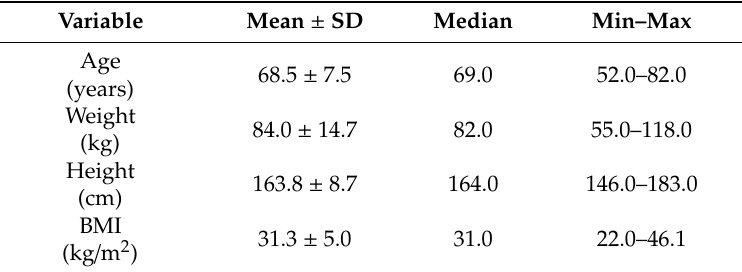
Table 1. Baseline demographics of the patients.